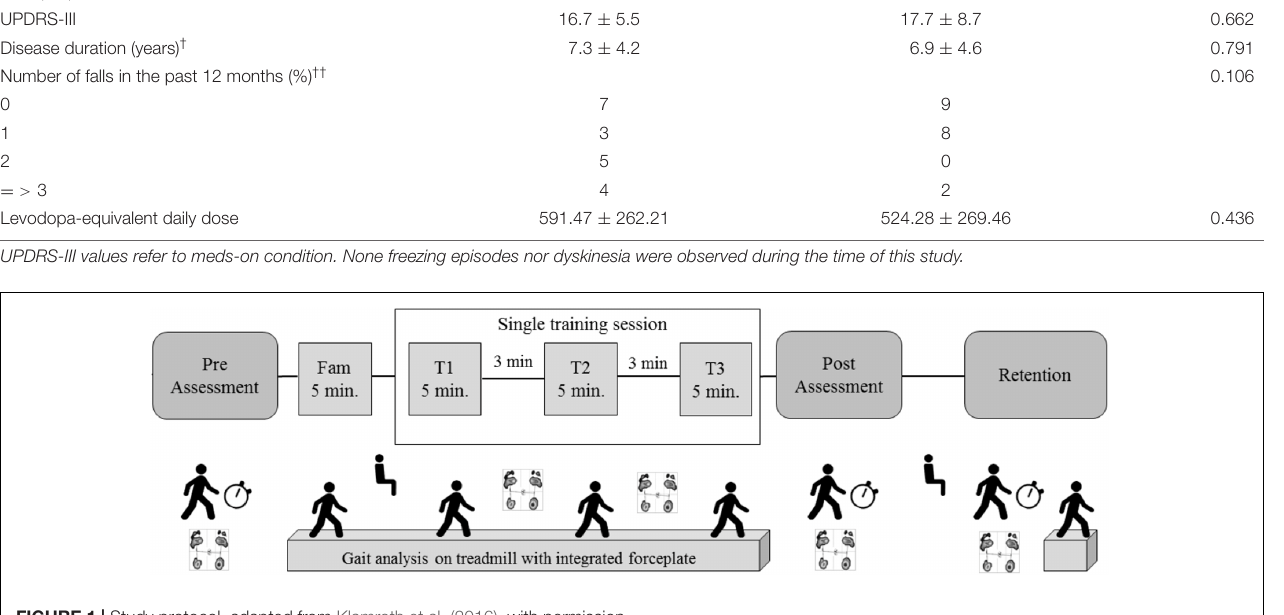
FIGURE 1 | Study protocol, adapted from Klamroth et al. (2016), with